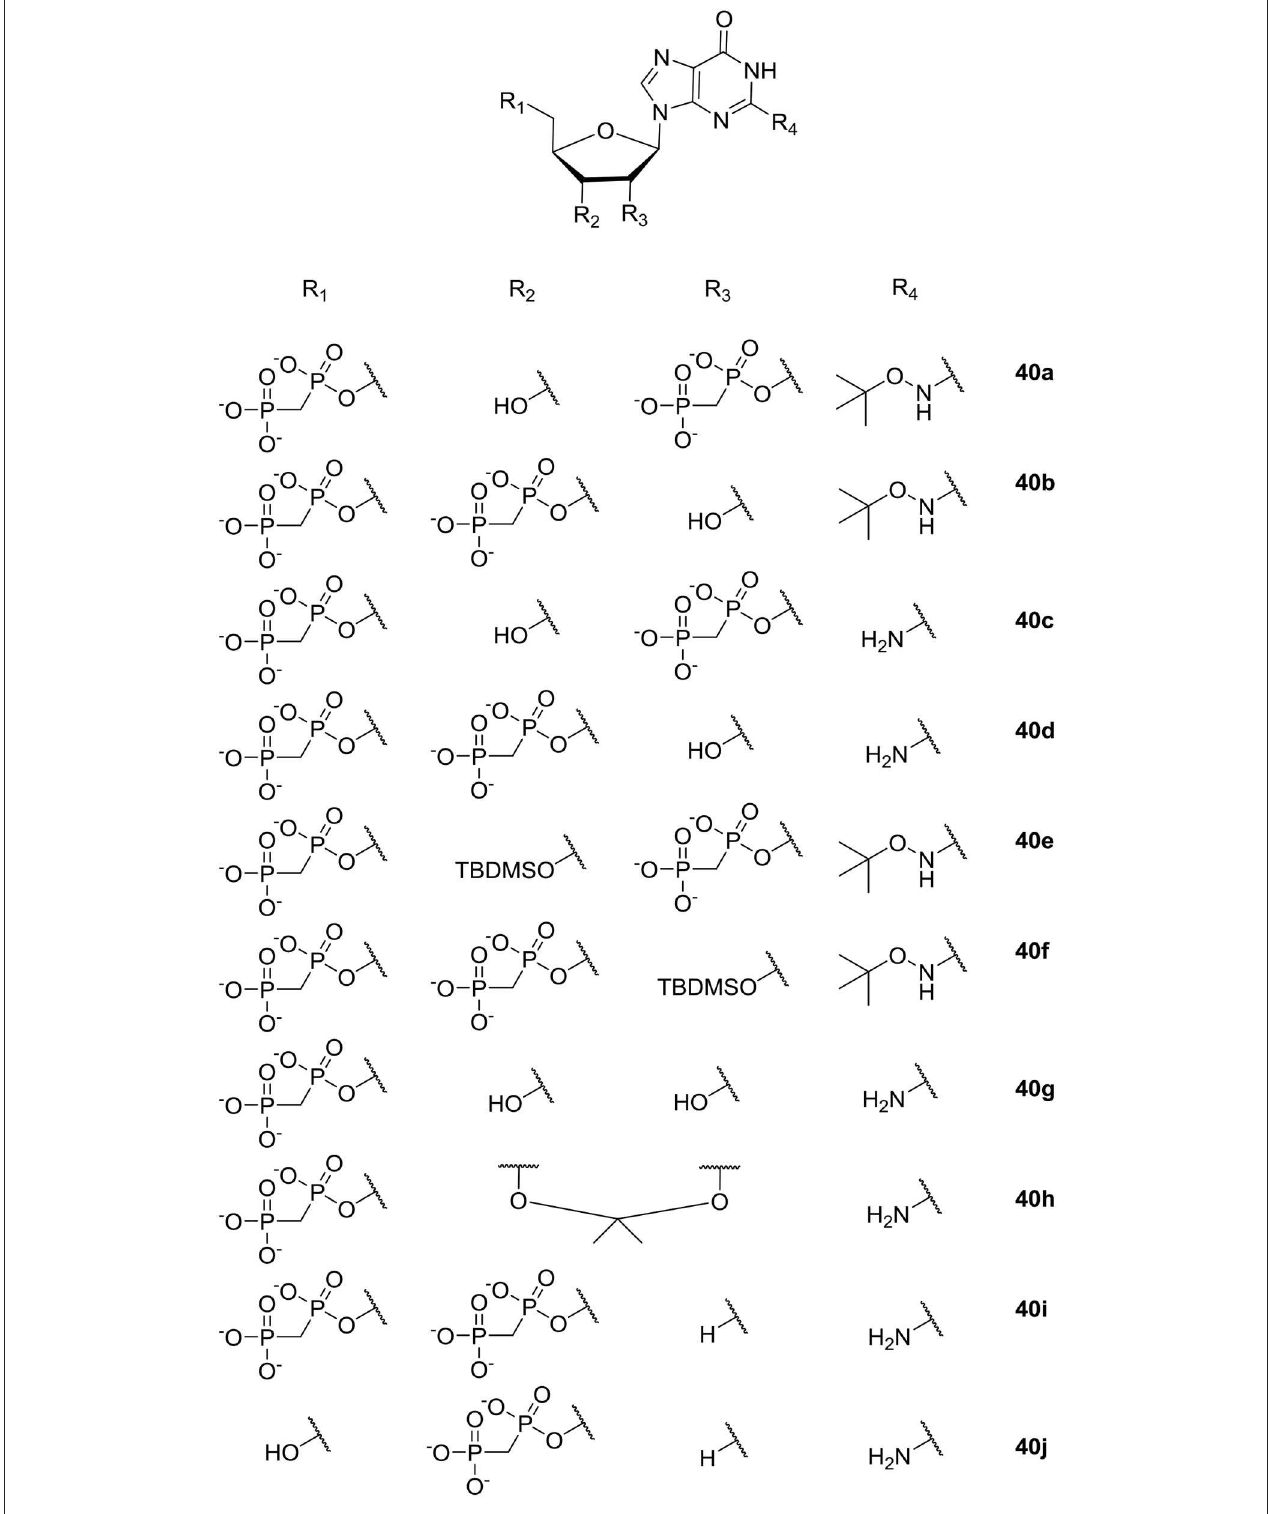
FIGURE 11 | ppGpp analogs studied by Wexselblatt et al. (2010).